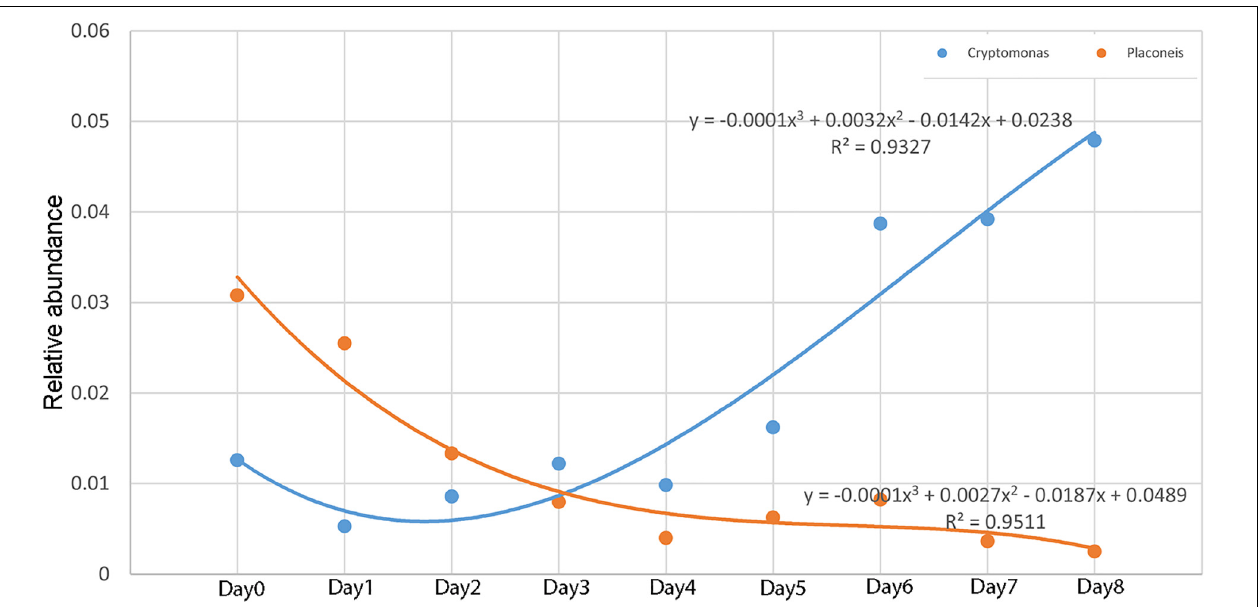
FIGURE 8 | Relative abundance changes of Cryptomonas and Placoneis with